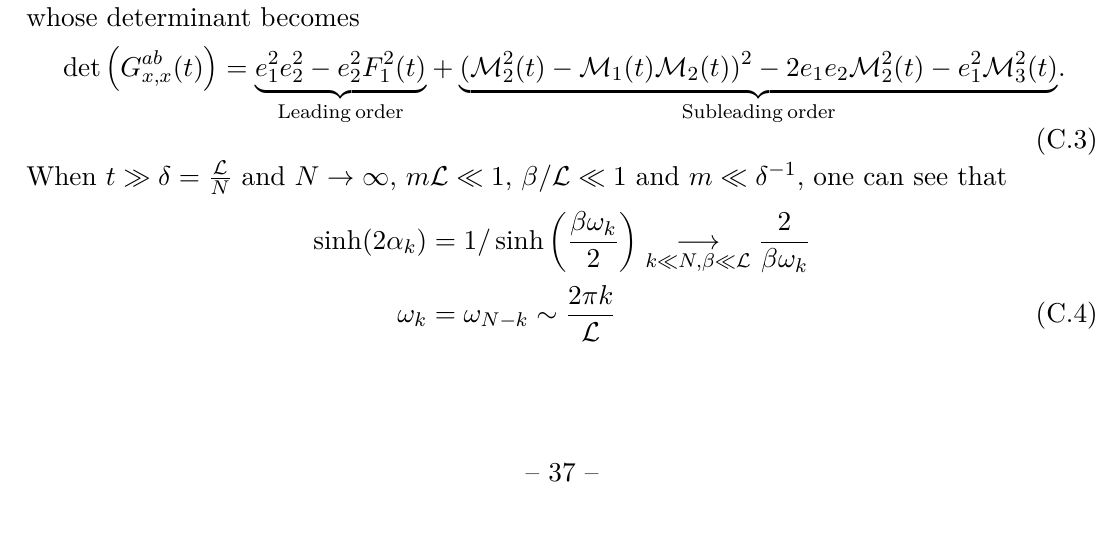
when N =1501 , N = N + N =20+31 th A L ( R ) A L 1( R 1) A L 2( R 2)